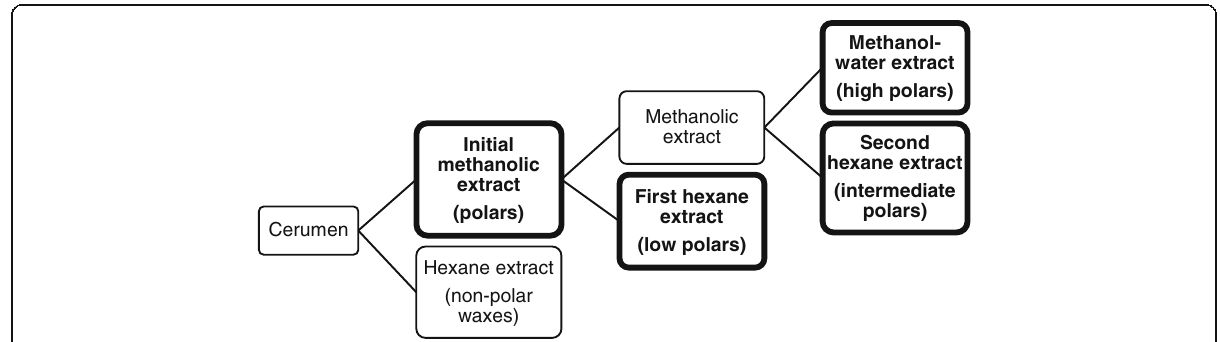
Fig. 1 Multi-solvent extraction of T. carbonaria cerumen. Cerumen was partitioned into extracts of increasing polarity. Extracts in bold were collected, dried and tested for free radical-scavenging activity and 5-LOX